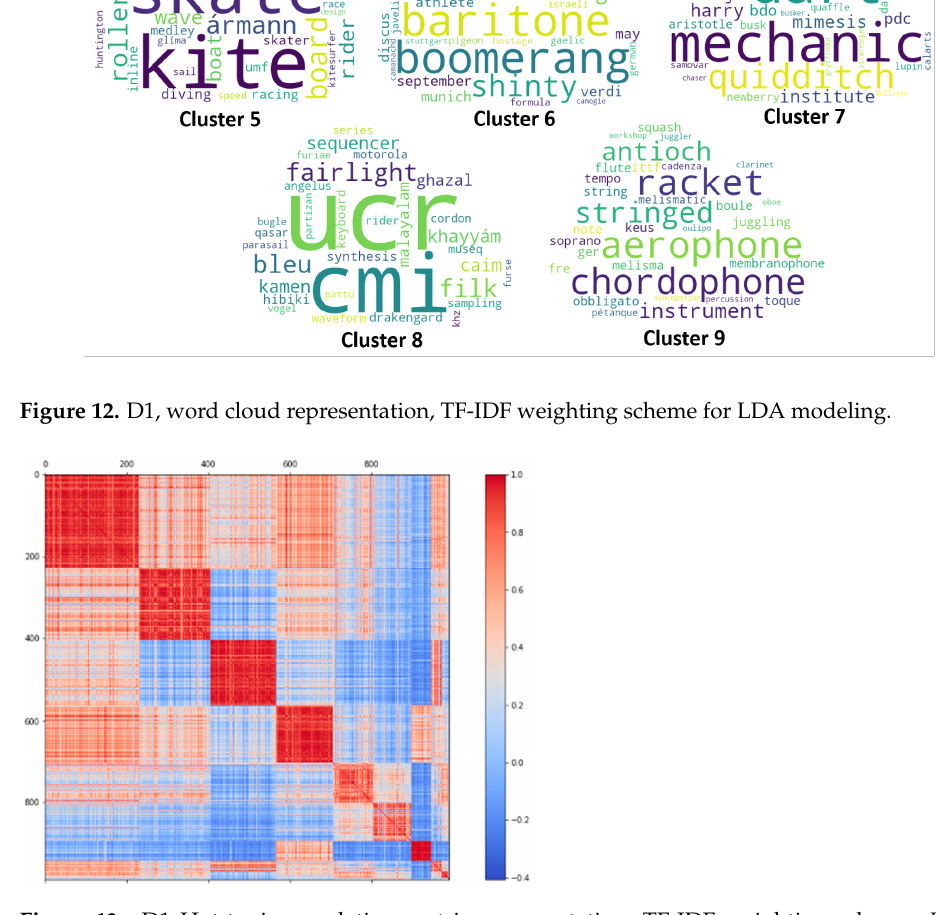
Figure 13. D1 Hot-topic correlation matrix representation, TF-IDF weighting scheme, K = 10,